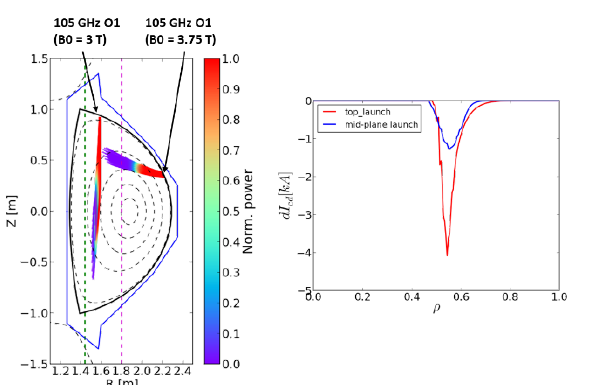
Fig. 10. The comparison of vertical top launch and outside midplane launch for the same harmonic EC frequency with the same density and temperature profiles with n e (0) = 7 x 10 19 m -3 , T e (0) = 7 keV.